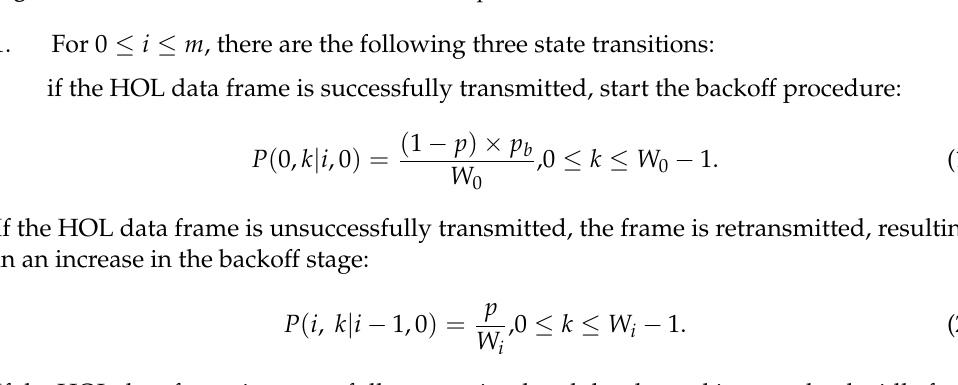
Figure 2. The 2 ‐ D Markov chain of IEEE 802.11 operations. Figure 2. The 2-D Markov chain of IEEE 802.11